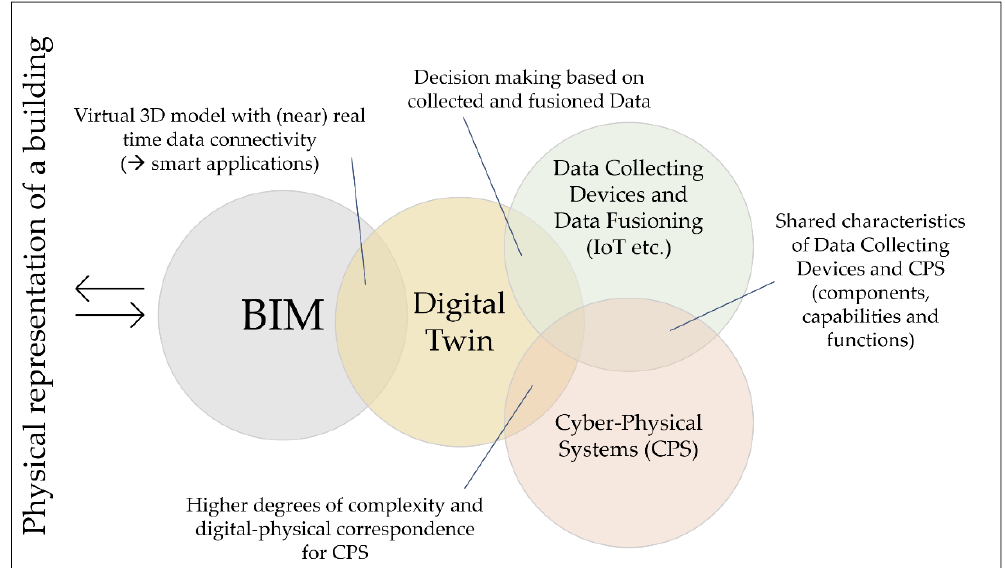
Figure 1. Allocation of Digital Twin, BIM, smart applications, data collecting, CPS based on [61].